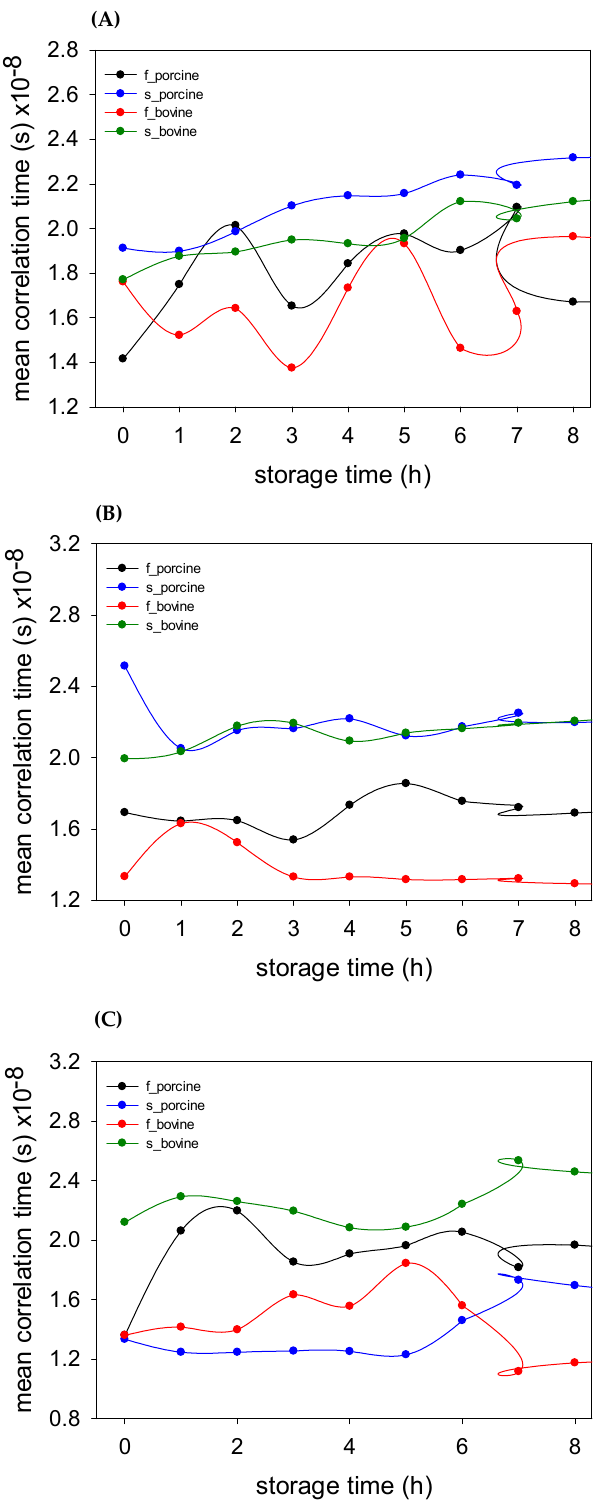
Figure 2. Time-related changes in the values of mean correlation times in O/W emulsions emulsified with ( A ) E 1420, ( B ) E 1412, and ( C ) LU 1432 starches. “f” and “s” denote the fat fraction and the starch fraction of the protons, respectively.